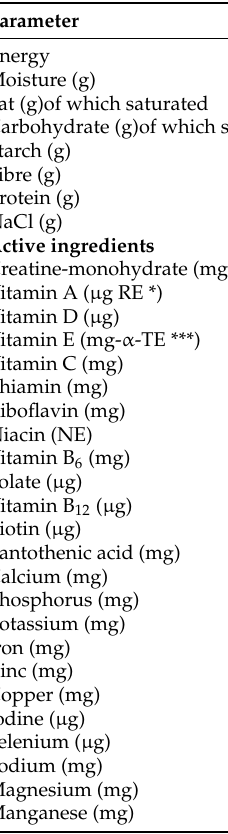
Table 1. The nutritional profile of the high-protein